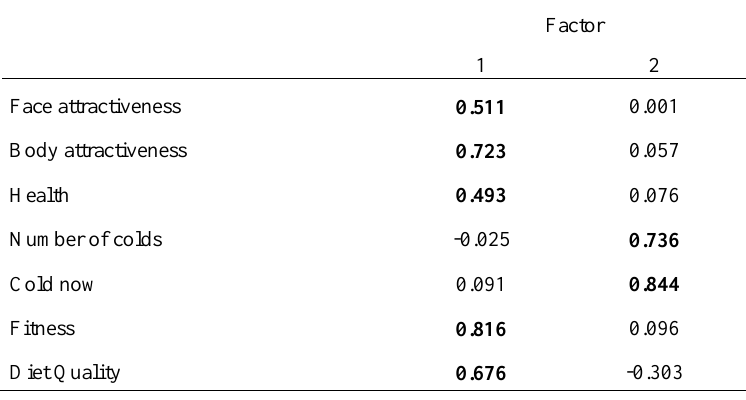
Factor Loadings for Each Question in the Principle Component Analysis with Varimax Rotation